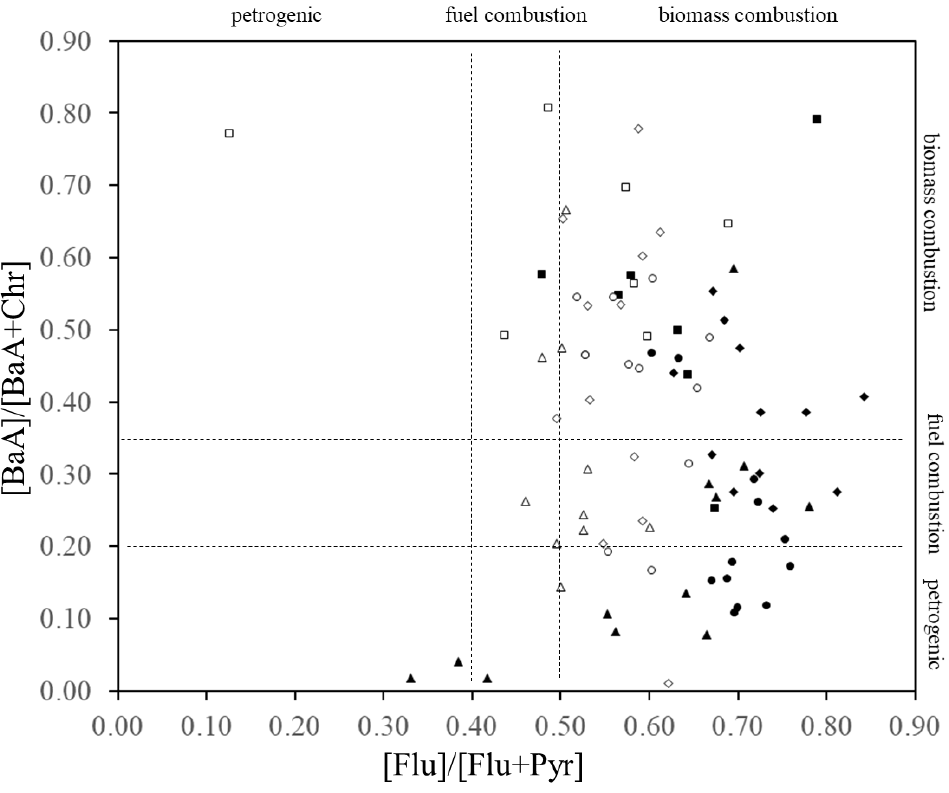
Figure 4. The relationship between the ratios of [BaA] / [BaA + Chr] and [Flu] / [Flu + Pyr]. Open and filled symbols represent the values of particulate and dissolved PAHs, respectively. Squares, triangles, diamonds and circles represent the data in 2015, 2016, 2017 and 2018.